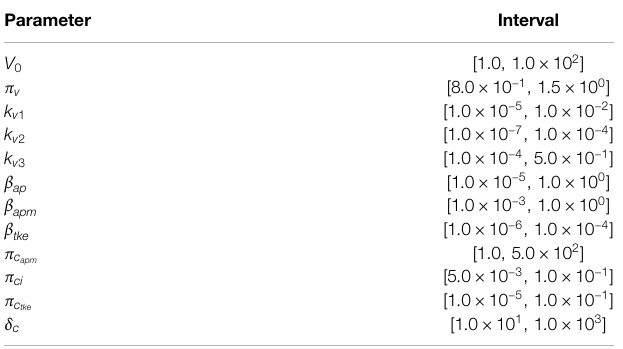
TABLE 2 | Bounds used for parameters calibration of the COVID-19 model for survivors. V 0 is the initial condition of the virus. Parameter Interval